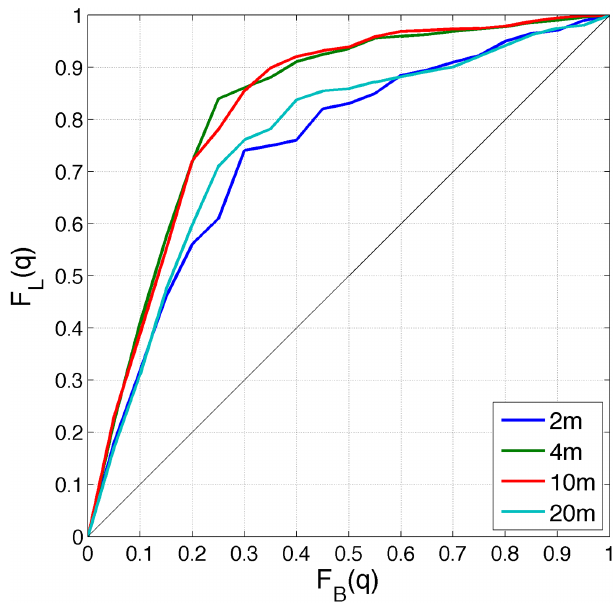
Figure 7. Relationship between cumulative frequencies F L ( q ) and F B ( q ) considering all landslides and for the DTM resolution of 2, 4, 10, and 20m. The q variable represents the return period for the QD-SLaM.